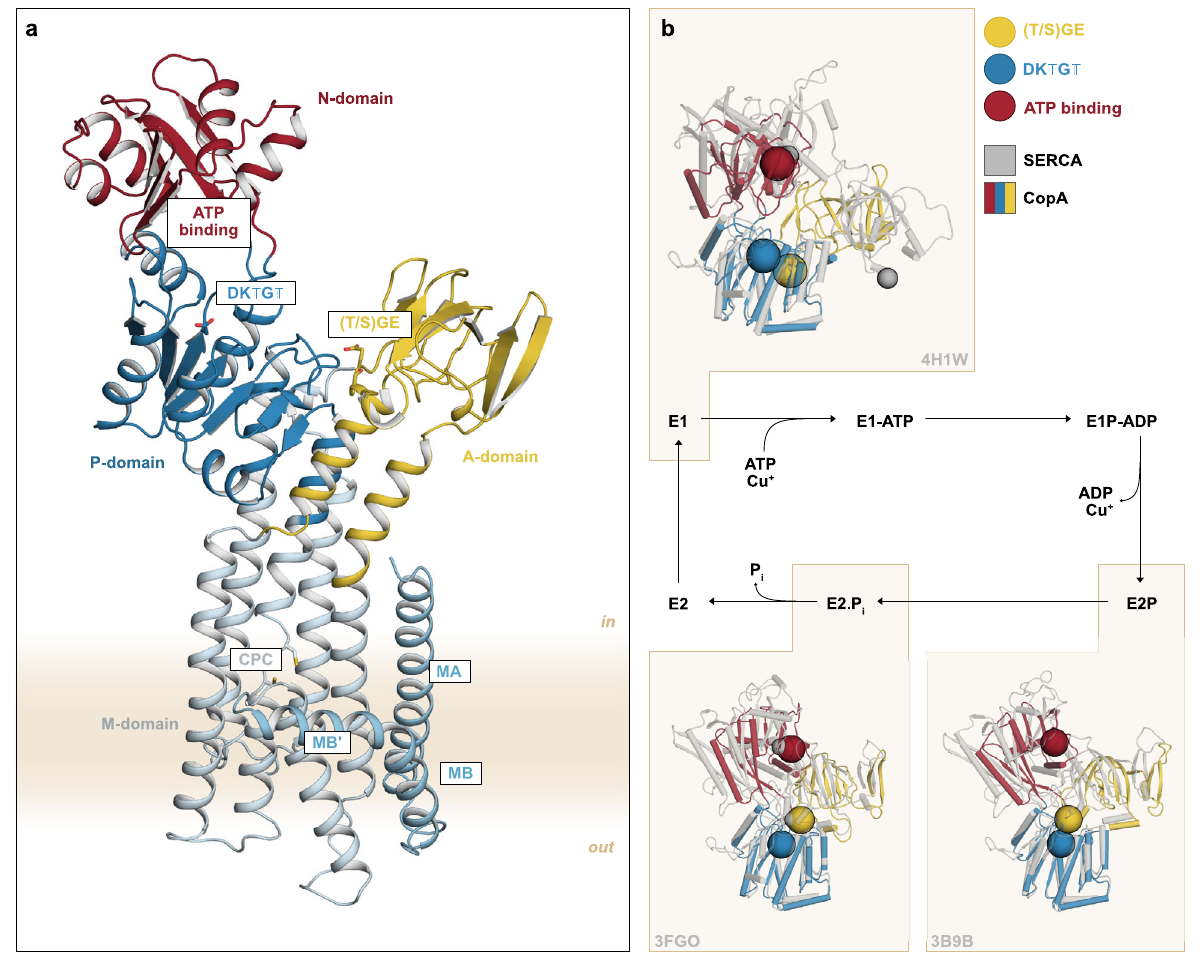
Fig. 1 | Overall structure of the E1 conformation. a The structure shows the typical P-type ATPase domain setup, with three cytosolic A- (colored in yellow), P- (blue) and N-(red)domains and a membrane-spanning M-domain. The P 1B -speci fi c MA-MBhelicesareshownincyanandM1-6ingrey.Functionallyimportantfeatures and motifs are highlighted. b Post-Albers reaction cycle. Insets demonstrate